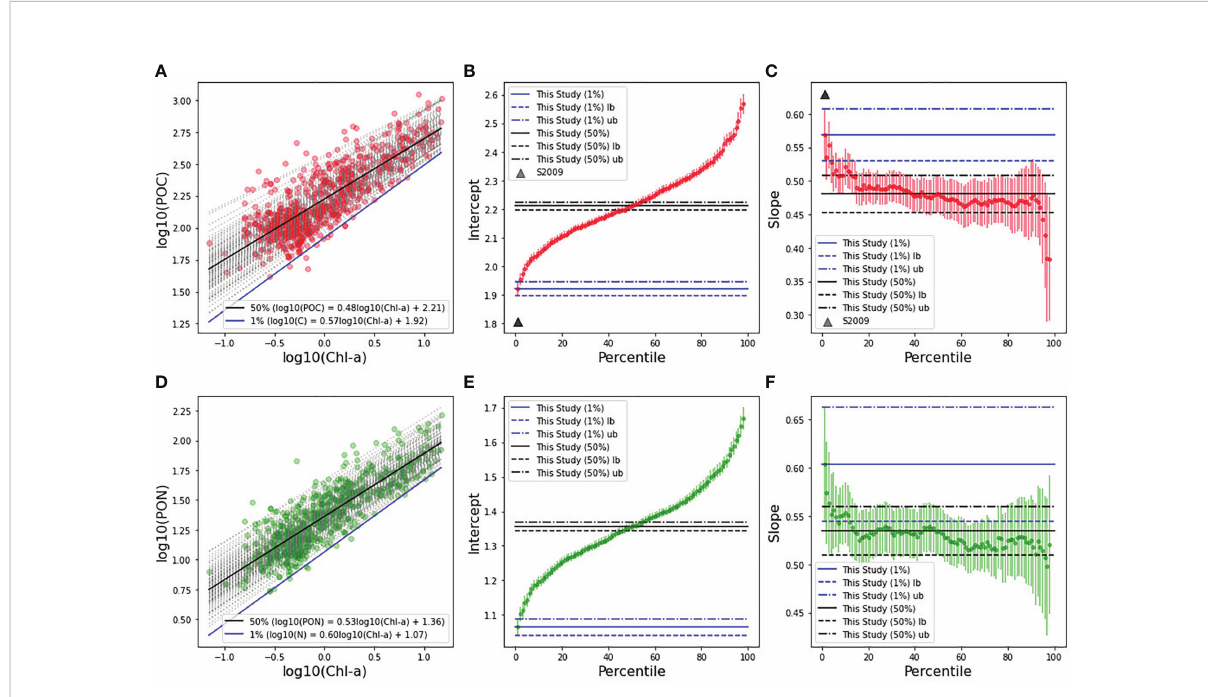
FIGURE 2 In-situ particulate carbon (top row) and nitrogen (bottom row), each plotted as a function of Turner chlorophyll-a from in-situ measurements. Least-squares fi ts to log 10 -transformed data, along with minimum carbon (Cphyto) and nitrogen (Nphyto) estimates by quantile regression (QR, q = 0.01) (A, D) . Quantile regression lines (from 1 to 99%) are plotted in grey dotted lines. The 1% percentile is highlighted in blue and the 50th percentile in black. Intercepts (B, E) and slopes (C, F) for the different quantile fi ts, including error margins for each regression line. 1% QRs and uncertainties (upper bounds, ub and lower bounds, lb) are shown by the continuous, dashed and dash-dotted lines in blue, (middle and right panels), while Sathyendranath et al. (2009) carbon parameter values are also displayed (triangle, panels B, C